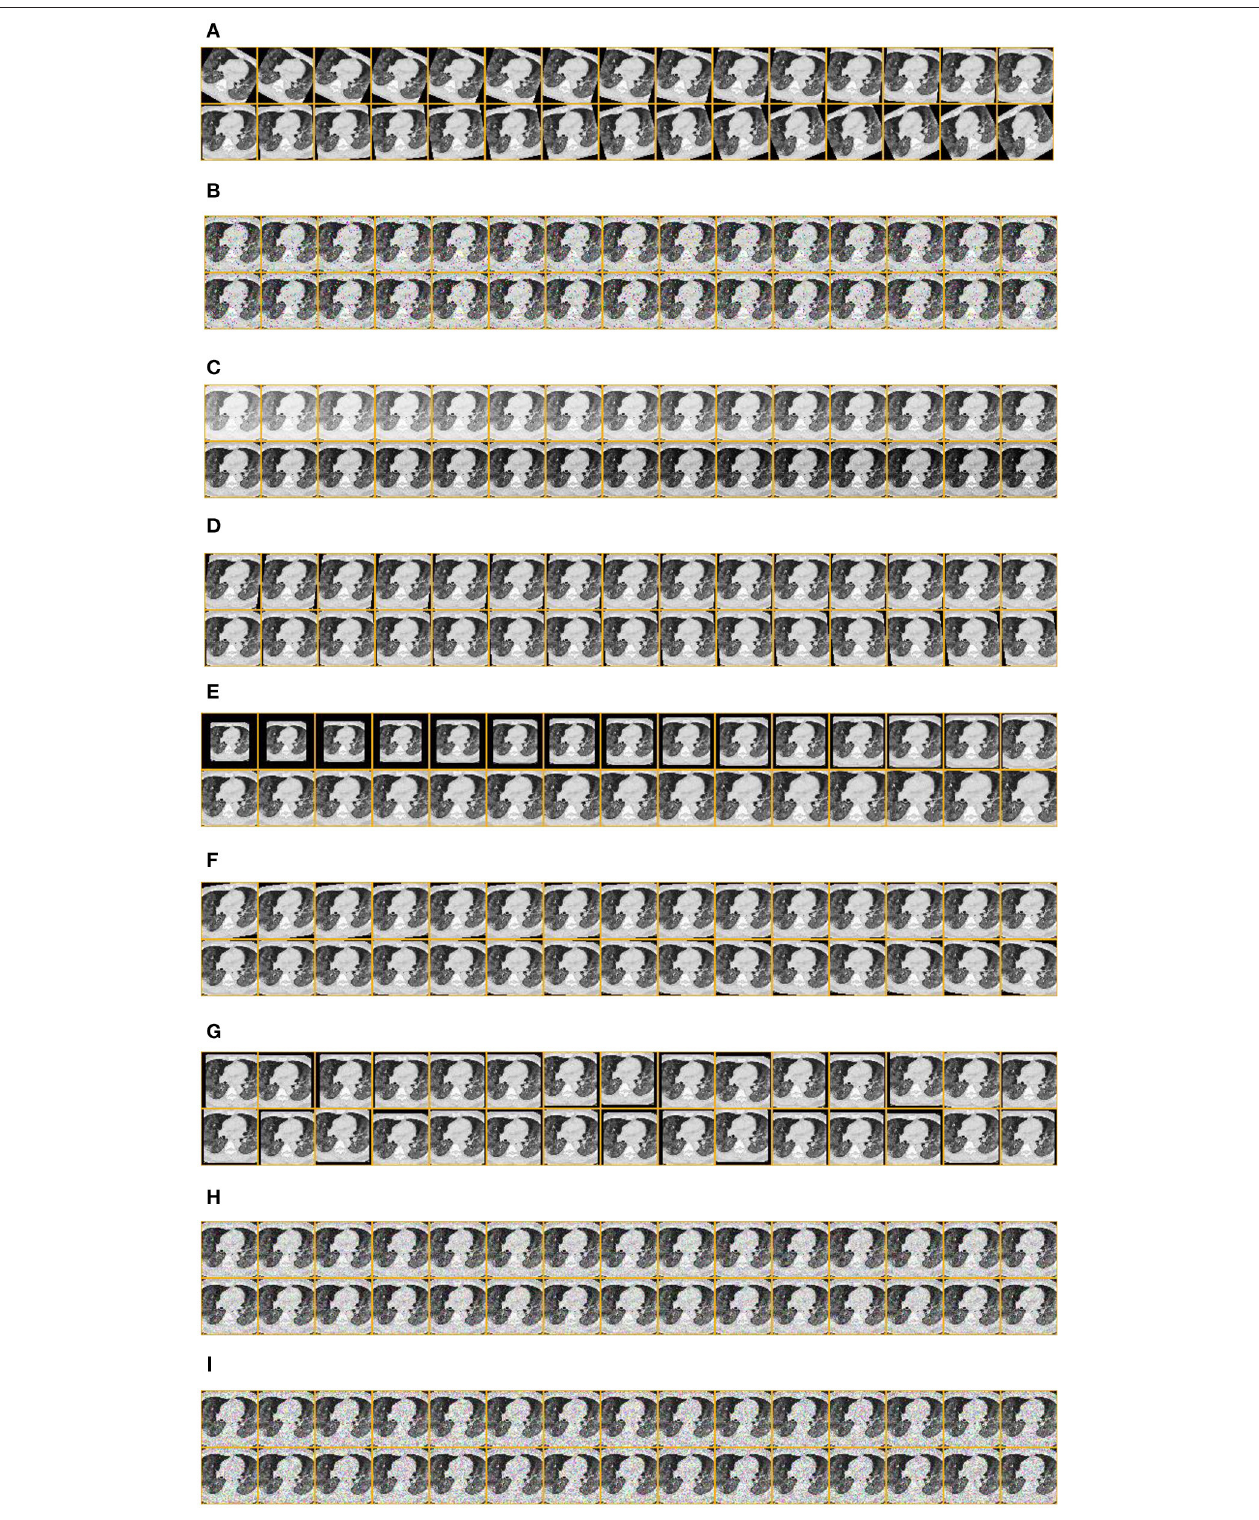
FIGURE 12 | Multiple-way data augmentation (MDA) results. (A) Image rotation. (B) Salt-and-pepper noise. (C) Gamma correction. (D) Horizontal shear. (E) Scaling. (F) Vertical shear. (G) Random translation. (H) Gaussian noise. (I) Speckle noise.